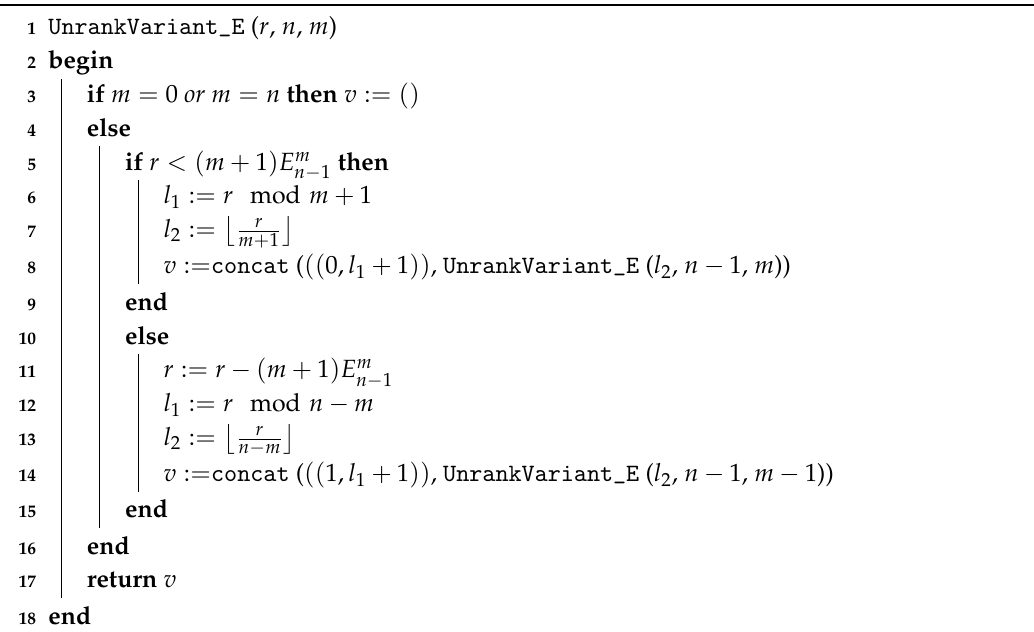
Algorithm 8: An algorithm for unranking the variants of the AND/OR tree for E m